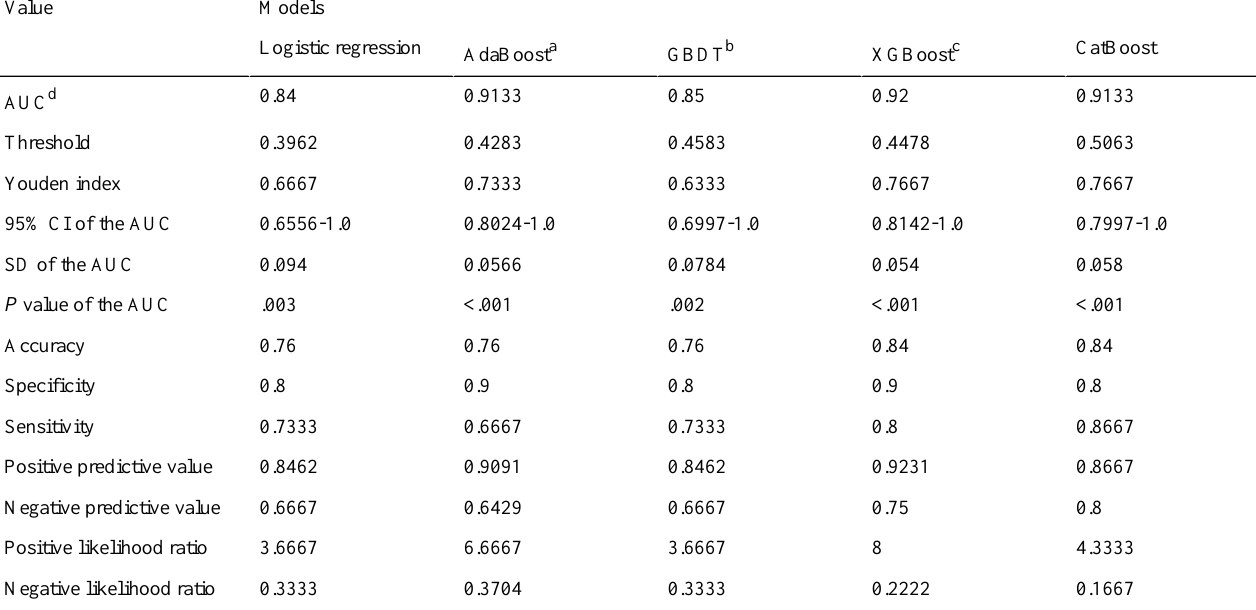
Table 1. Summary of prediction results of multiple models on the test